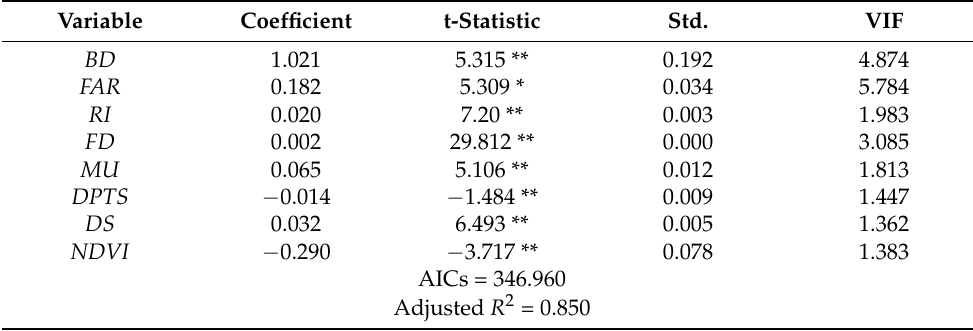
Table 3. Regression results of urban vitality by OLS model on weekdays.